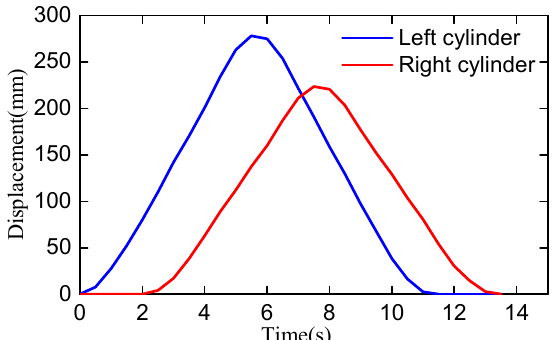
Figure 3. Displacements of two driving cylinders in a hydraulic rolling shear.